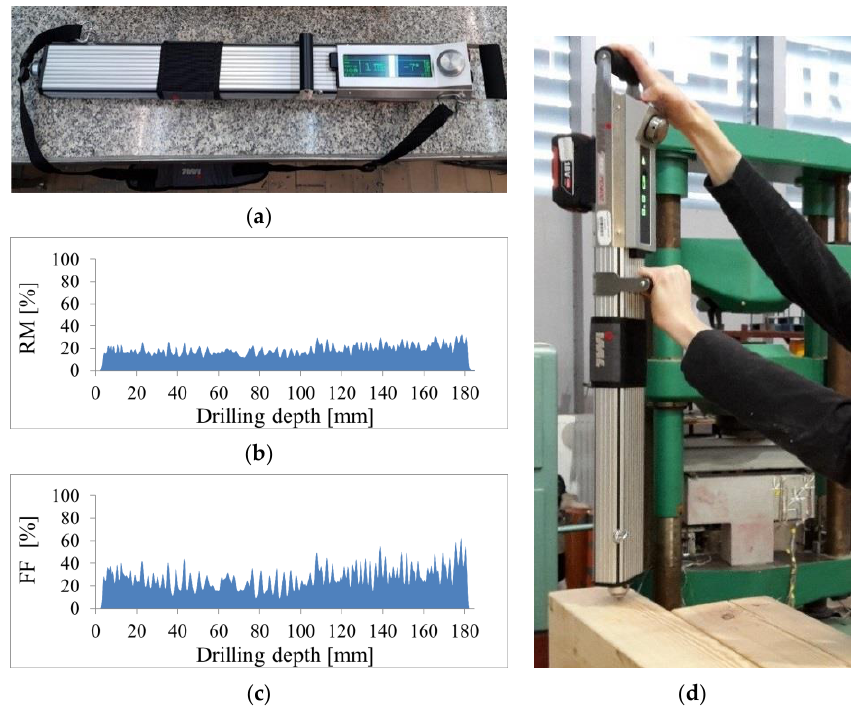
Figure 3. Drilling resistance test ( a ) device IML RESI PD-400S used in tests ( b , c ) charts obtained from test ( d ) test procedure.